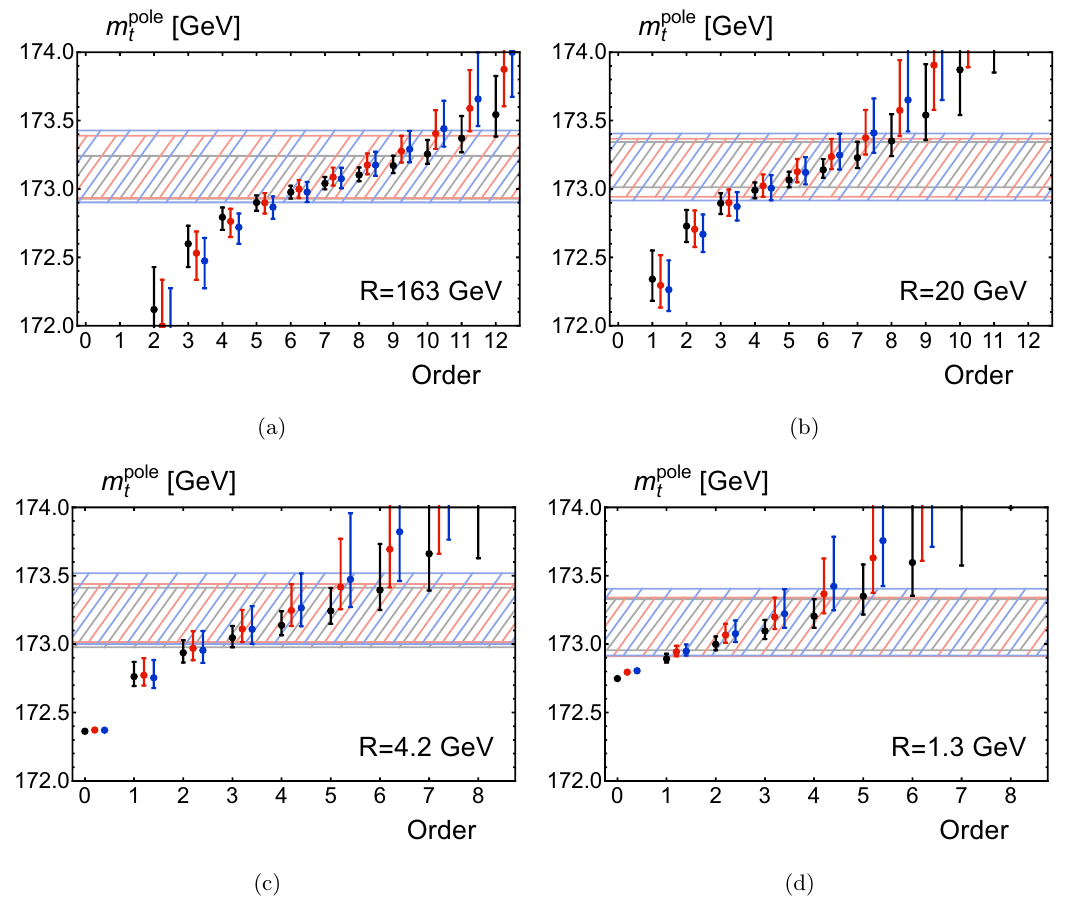
Figure 6 . Top quark pole mass m pole as a function of order taking m t = m t ( m t ) = 163 GeV t as input and using di(cid:11)erent methods to obtain the best possible estimate and the ambiguity. The central dots are obtained for the default renormalization scales for the strong coupling and the error bands represent the scale variation as explained in the text. The light colored hatched horizontal bands bounded by equal colored lines show the best possible estimate for the respective method also given in the last column in table 5. All results obtained for massless bottom and charm quarks are in black, all results for ( m b ; m c ) = (4 : 2 ; 0) GeV are in red, all results for ( m b ; m c ) = (4 : 2 ; 1 : 3) GeV are in blue. Panel (a) shows results for R = 163 GeV, panel (b) for R = 20 GeV, panel (c) for R = 4 : 2 GeV and panel (d) for R = 1 : 3